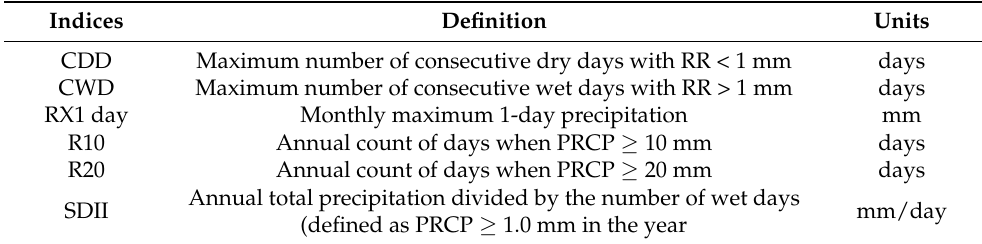
Table 1. Extreme precipitation indices.